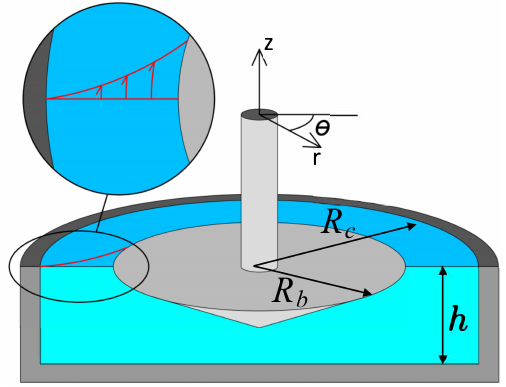
Figure 2. Schematic of the bicone